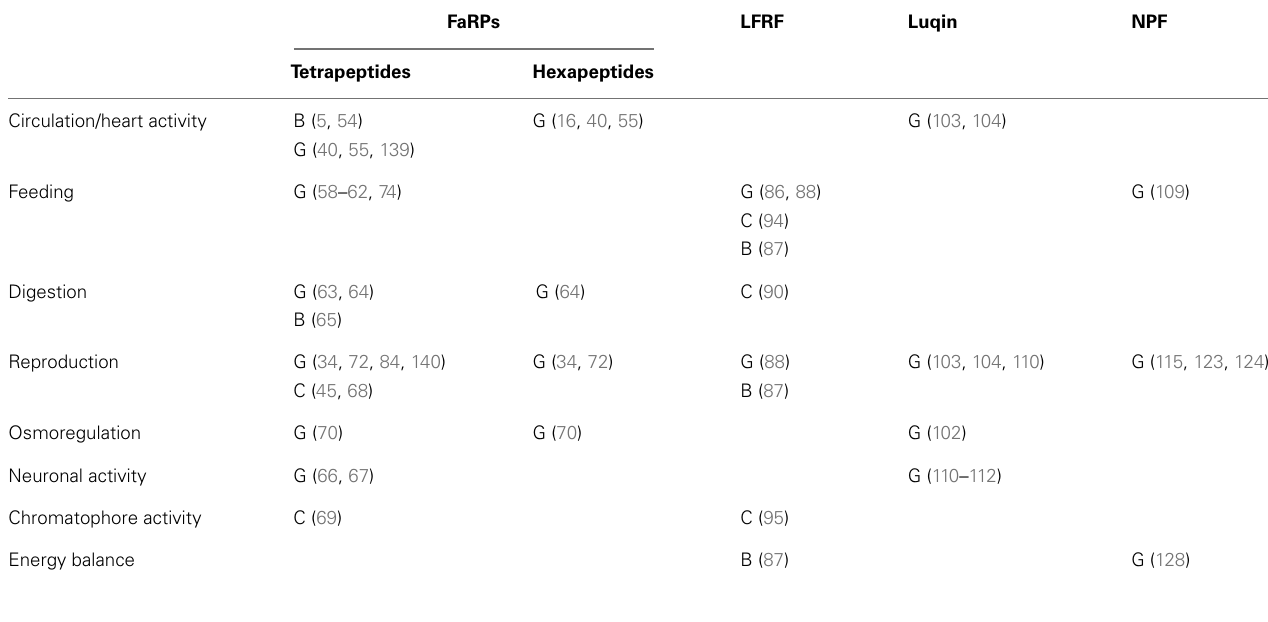
Table 7 | Functional involvement of RFamide-like peptides in the three main mollusk classes: B, Bivalves; C, Cephalopods; G, Gastropods .